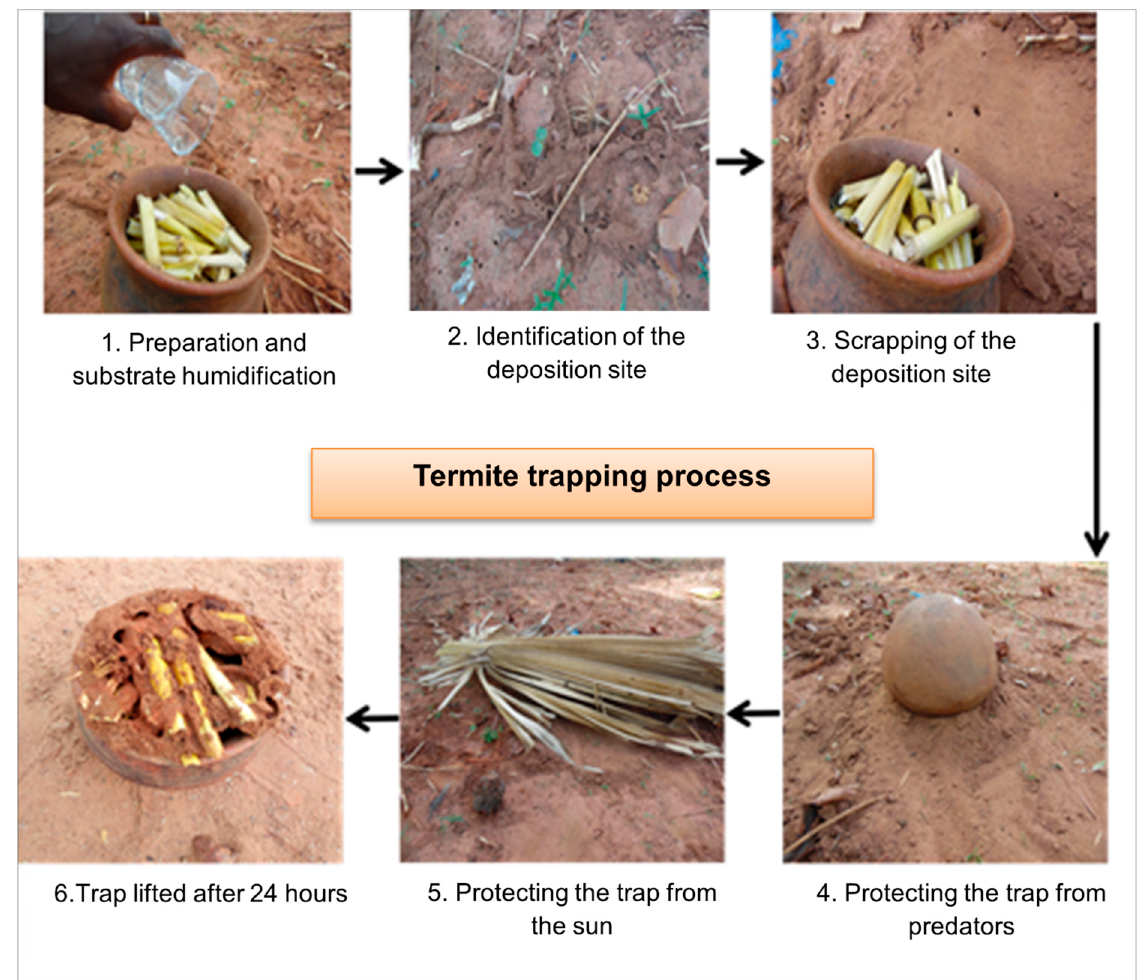
Figure 3. Termite trapping